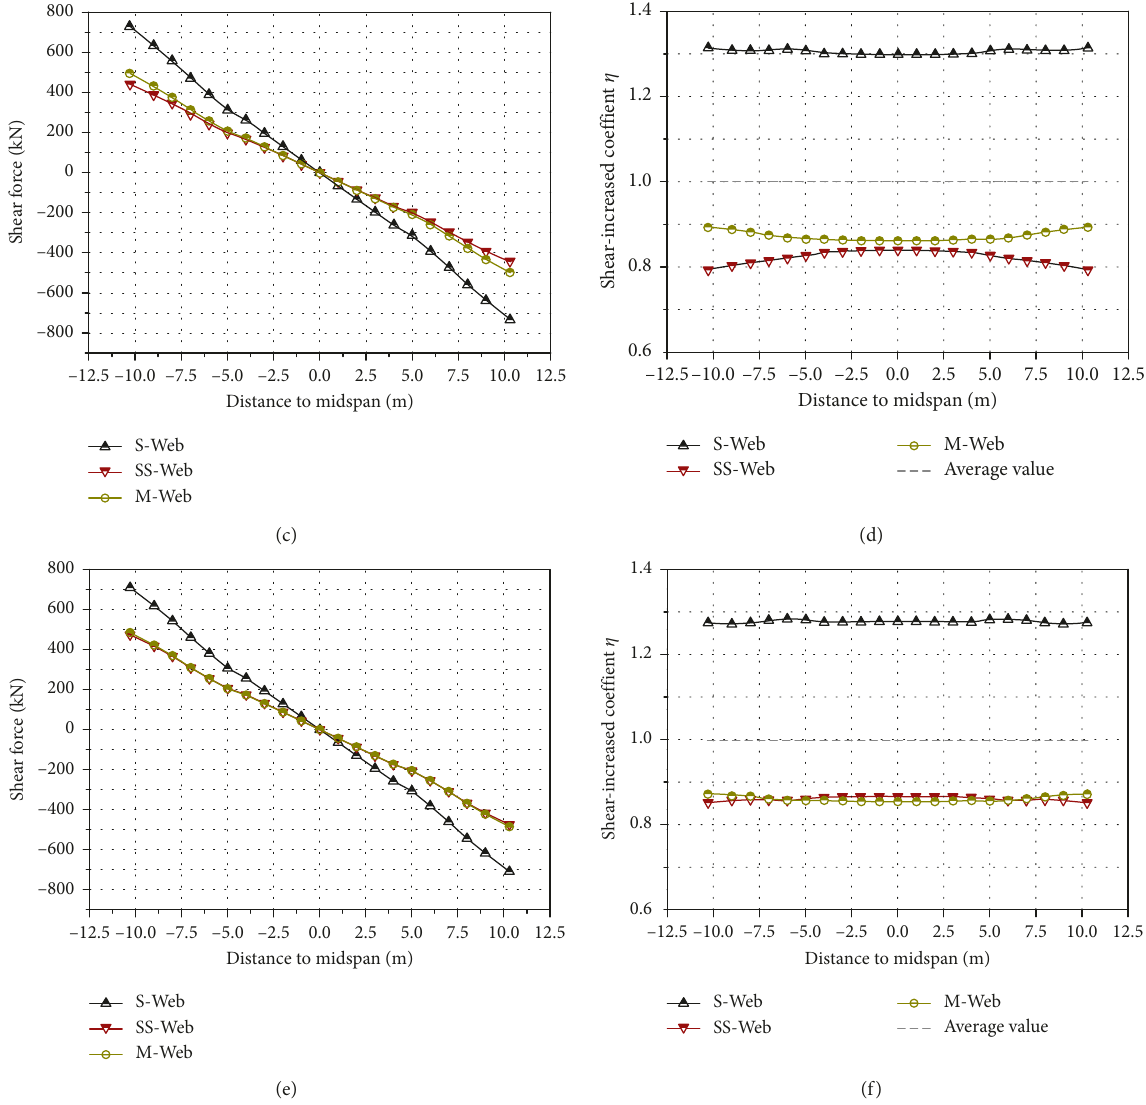
Figure 6: Shear distribution and shear-increased coefficient η of the webs with different support cases. (a) Shear value of each web in model SPT-2. (b) Shear-increased coefficient of each web η in model SPT-2. (c) Shear value of each web in model SPT-3. (d) Shear-increased coefficient of each web η in model SPT-3. (e) Shear value of each web in model SPT-4. (f) Shear-increased coefficient of each web η in model